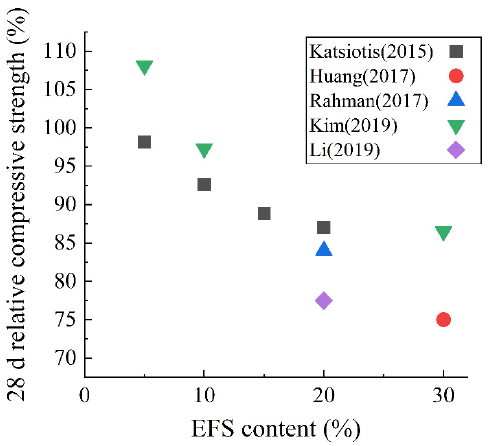
Figure 12. The 28 d relative compressive strength of hardened paste with EFS as an SCM [70,72,78,100,101].